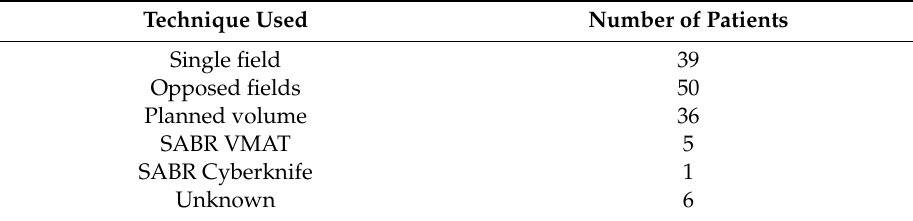
Table 3. Radiotherapy technique used.